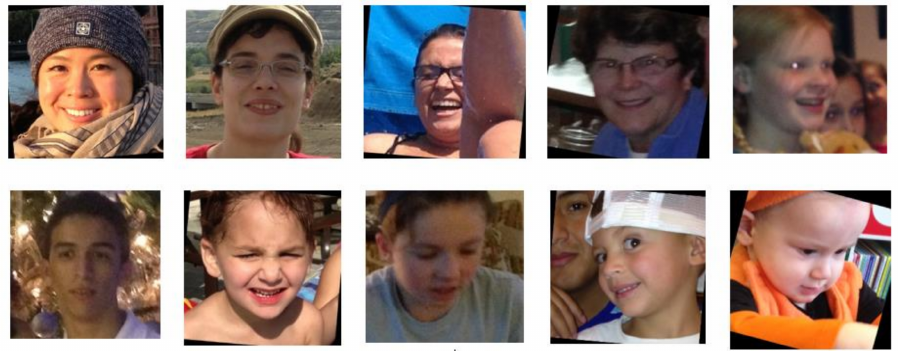
Figure 14. A pictorial presentation of some of the misclassified test images from the Adience dataset evaluated by our model. ( Top row ): Female subjects are misclassified as males. ( Bottom row ): Male subjects are misclassified as